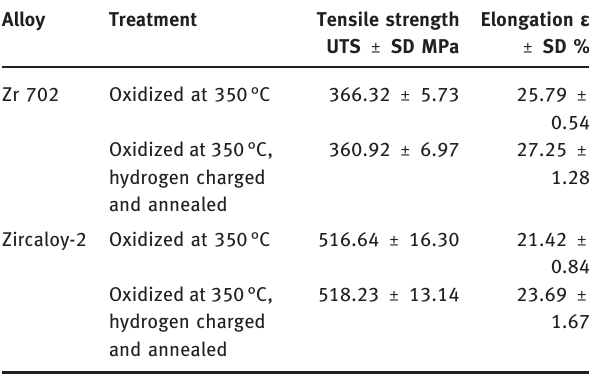
Table 2: The tensile strength and elongation for no charged and hydrogen charged alloys, as measured in slow strain rate